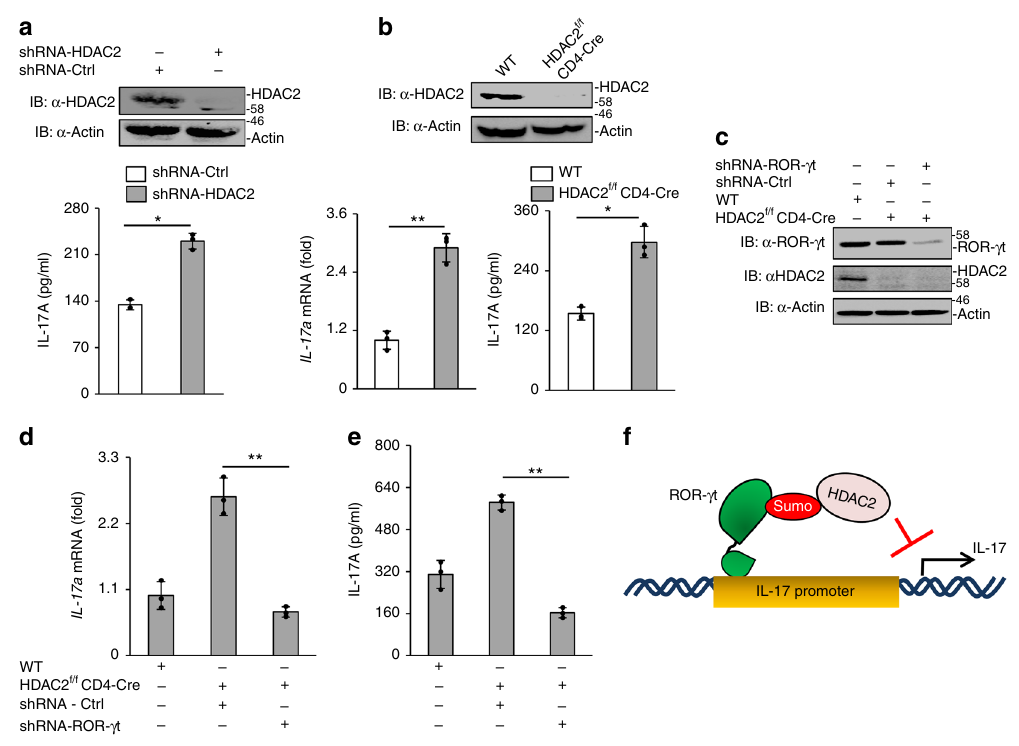
Fig. 5 HDAC2 inhibits IL-17 expression. a Knockdown of HDAC2 in cLPLs of WT mice using shRNA. ELISA was performed to measure IL-17A secretion in the culture supernatant of WT cLPLs treated with HDAC2-speci fi c shRNA (shHDAC2) or control shRNA (shCtrl). b CD4 + T cells were isolated from WT and HDAC2 f/f CD4-Cre mice and were differentiated under Th17-inducing conditions. Real-time PCR and ELISA were performed to measure IL-17A expression. c Immunoblot analysis was performed to check the knockdown of ROR- γ t in CD4 + T cells isolated from HDAC2 f/f CD4-Cre mice using ROR- γ t-speci fi c shRNA and differentiated under Th17-inducing conditions. d ELISA and e real-time PCR were performed to measure IL-17A expression in HDAC2 f/f CD4-Cre cells treated with ROR- γ t-speci fi c shRNA or control shRNA. f Schematic drawing of model shows that SUMOylation of ROR- γ t facilitates recruitment of HDAC2, which inhibits IL-17 expression. Data are from one experiment representative of three or more independent experiments with similar results. * p < 0.05 and ** p < 0.01, ns non-signi fi cant (two-tail t test) error bars are